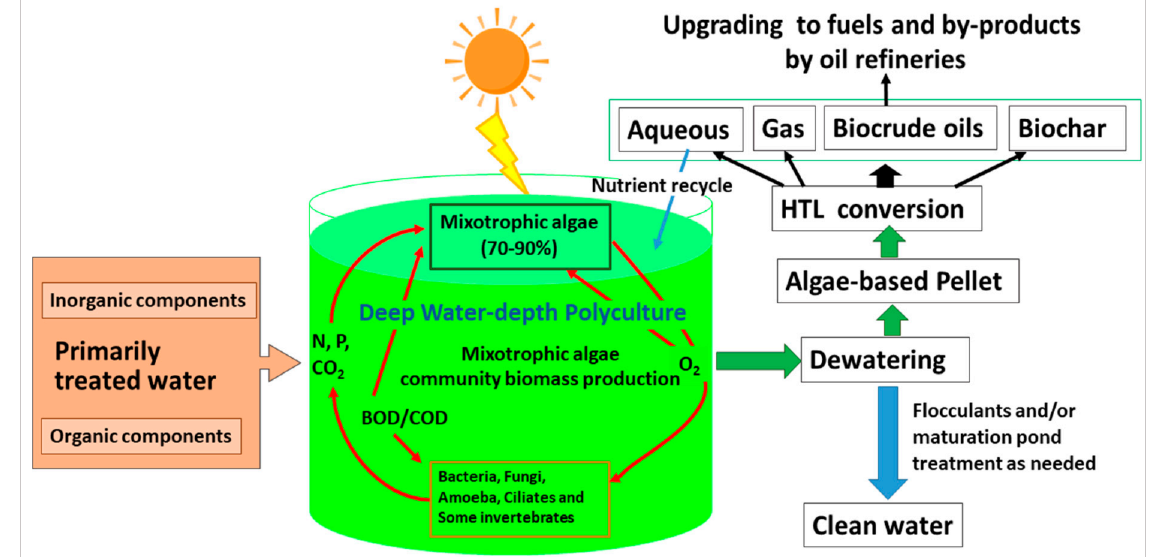
Figure 5. Diagram of biocrude oil production by deep-depth polyculture integrating mixotrophic algae community biomass production and wastewater